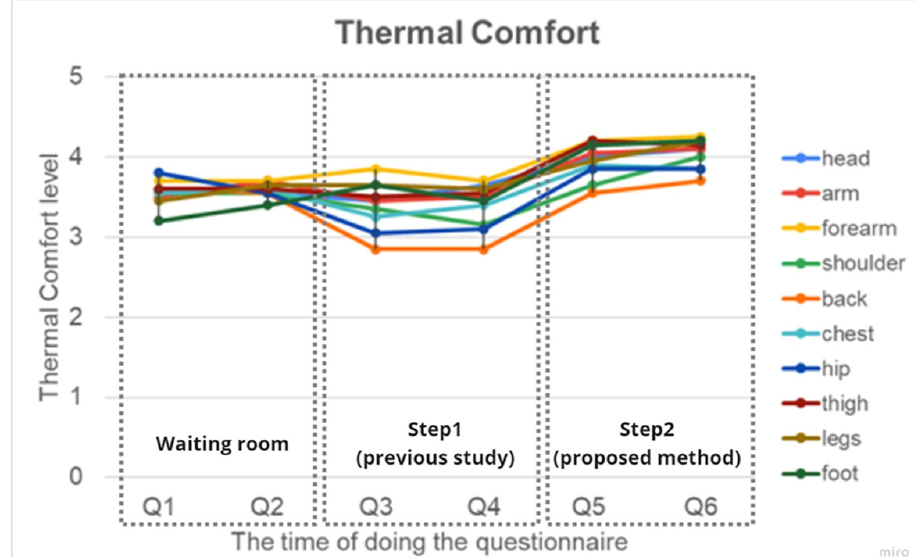
Figure 12. Average thermal comfort for each part of the body.